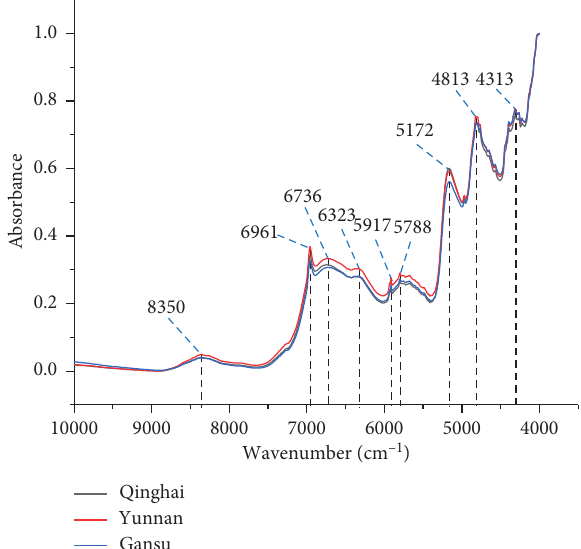
Figure 2: Average raw NIR spectra of ASR samples from three different geographical origins.